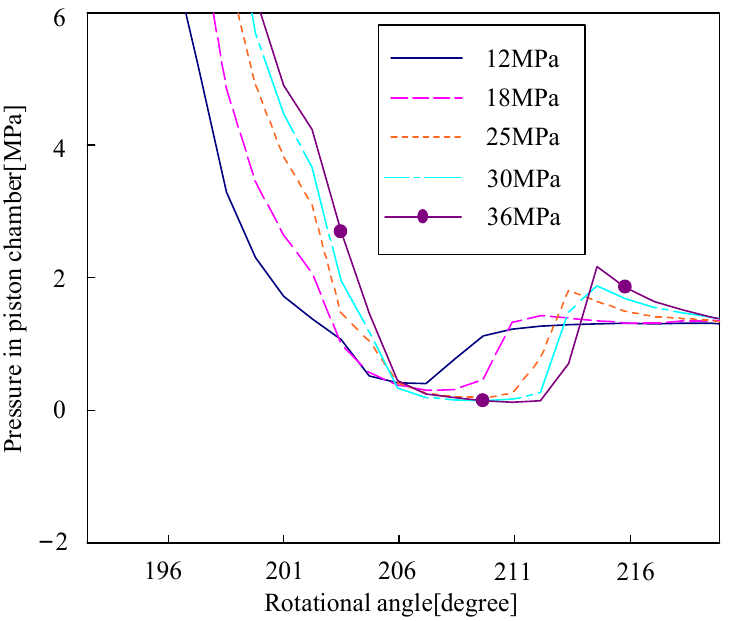
Figure 20. Pressure in the piston chamber with different outlet pressure at the beginning of the suction phase.